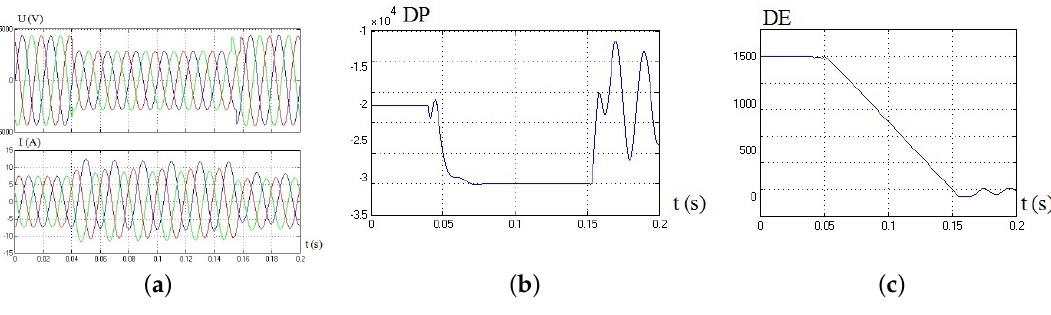
Figure 10. Disturbance signals for Case 1: ( a ) voltage and current at F ; ( b ) DP signal ( c ) DE signal.